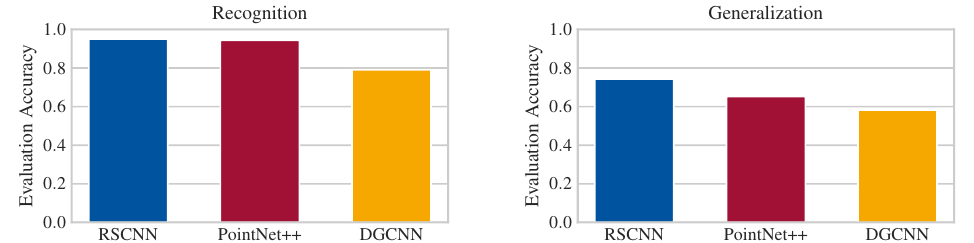
Figure 10. Evaluation accuracies of different neural network architectures with respect to the split of the data set.